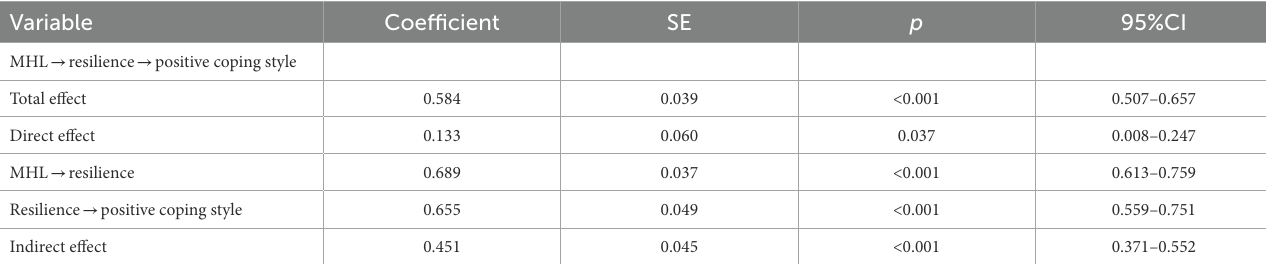
TABLE 6 The mediating effect of resilience on MHL and positive coping style. Variable